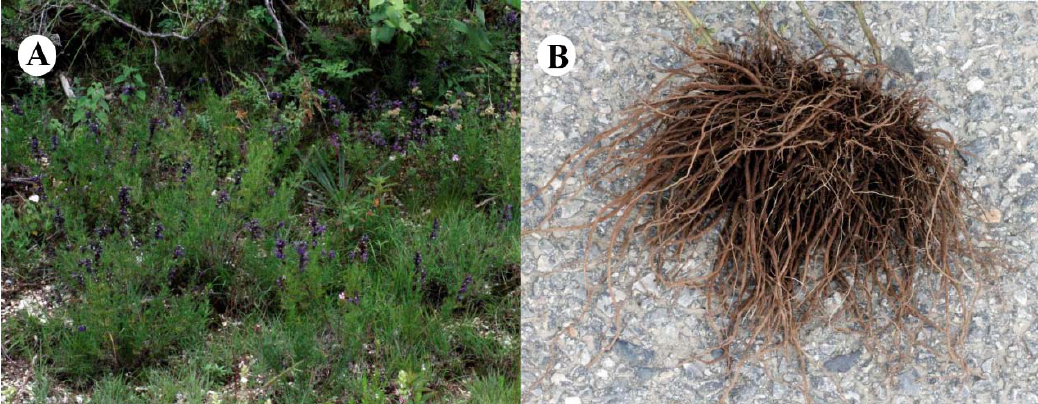
Figure 1. The ecological habitats ( A ) and roots ( B ) of D. taliense .